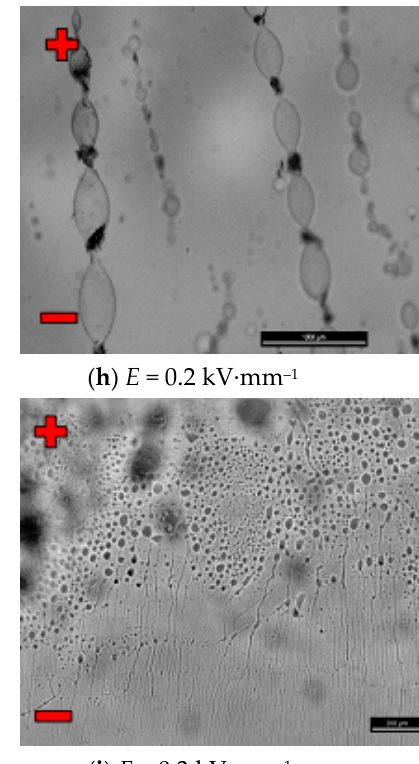
Figure 14. ( a – j ): Mixture PAO6 + CJ008 in an electric field observed under Nikon Eclipse LV100D pola-rizing microscope.